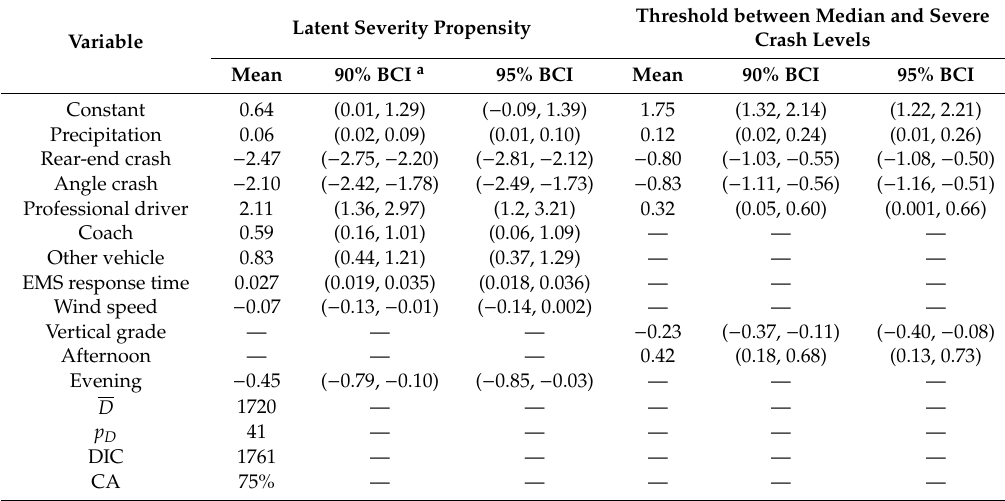
Table 2. Estimation and assessment results for the generalized ordered logit model. Variable